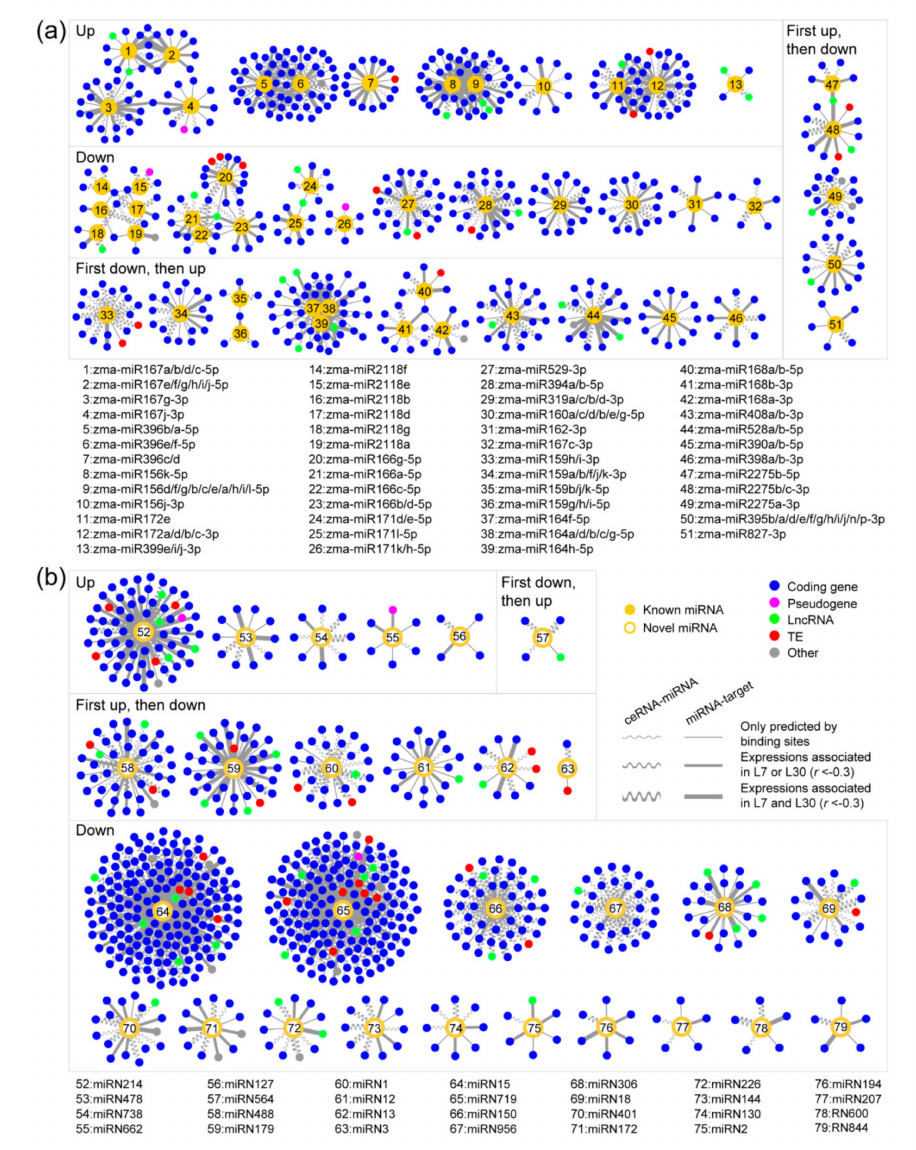
Figure 4. The 79 ceRNA-miRNA-target gene regulatory networks in the developing maize anther. There were ( a ) 51 known miRNA-mediated and ( b ) 28 potentially novel miRNA-mediated ceRNA-miRNA-target gene regulatory networks. The 51 known miRNA-mediated networks were first classified into four categories (i.e., “Up”, “Down”, “First up, then down”, and “First down, then up”) based on the expression patterns of known miRNAs shown in Figure 2, and then were numbered from “1” to “51”. The 28 potentially novel miRNA-mediated regulatory networks were also classified and numbered from “52” to “79”. Please refer to Table S5 for the detailed information of ceRNAs, miRNAs, and target genes located in the 79 regulatory